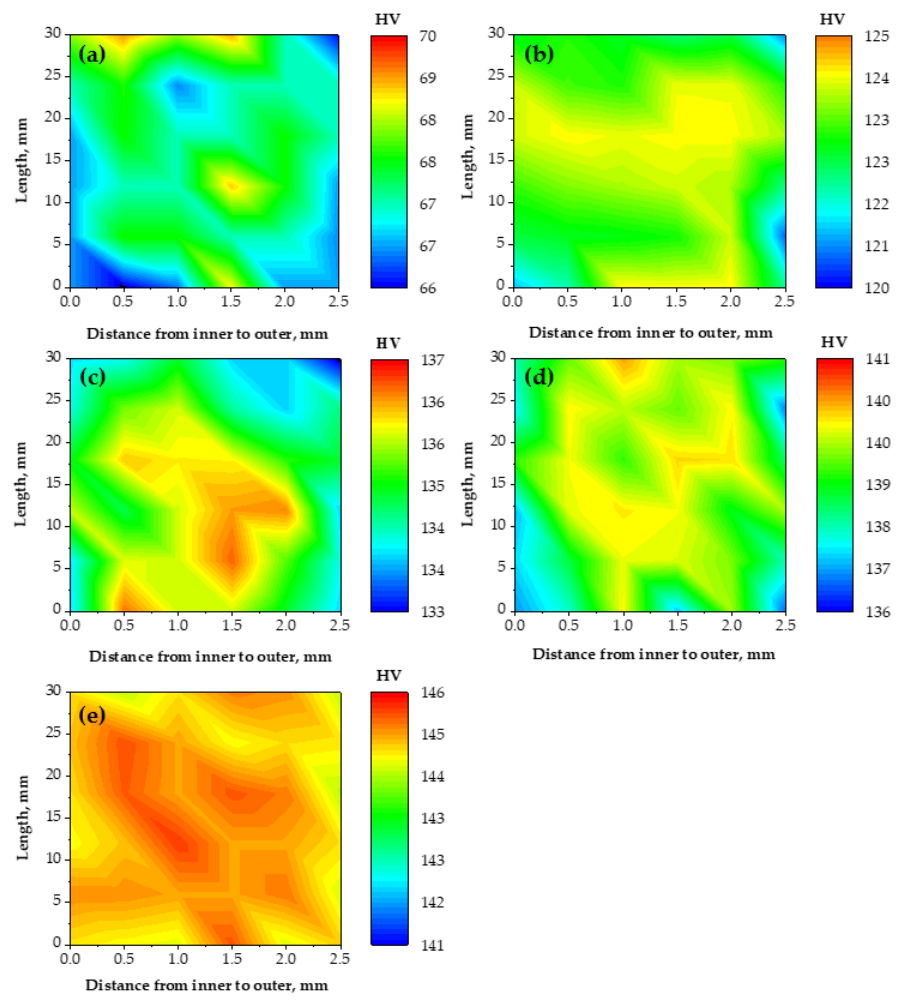
Figure 7. Hardness distribution map of the copper tube along the tube thickness cross-section with distance from the inner to the outer: ( a ) annealed, and after PTCAP processing of ( b ) 1 pass, ( c ) 2 passes, ( d ) 3 passes, ( e ) 4 passes.